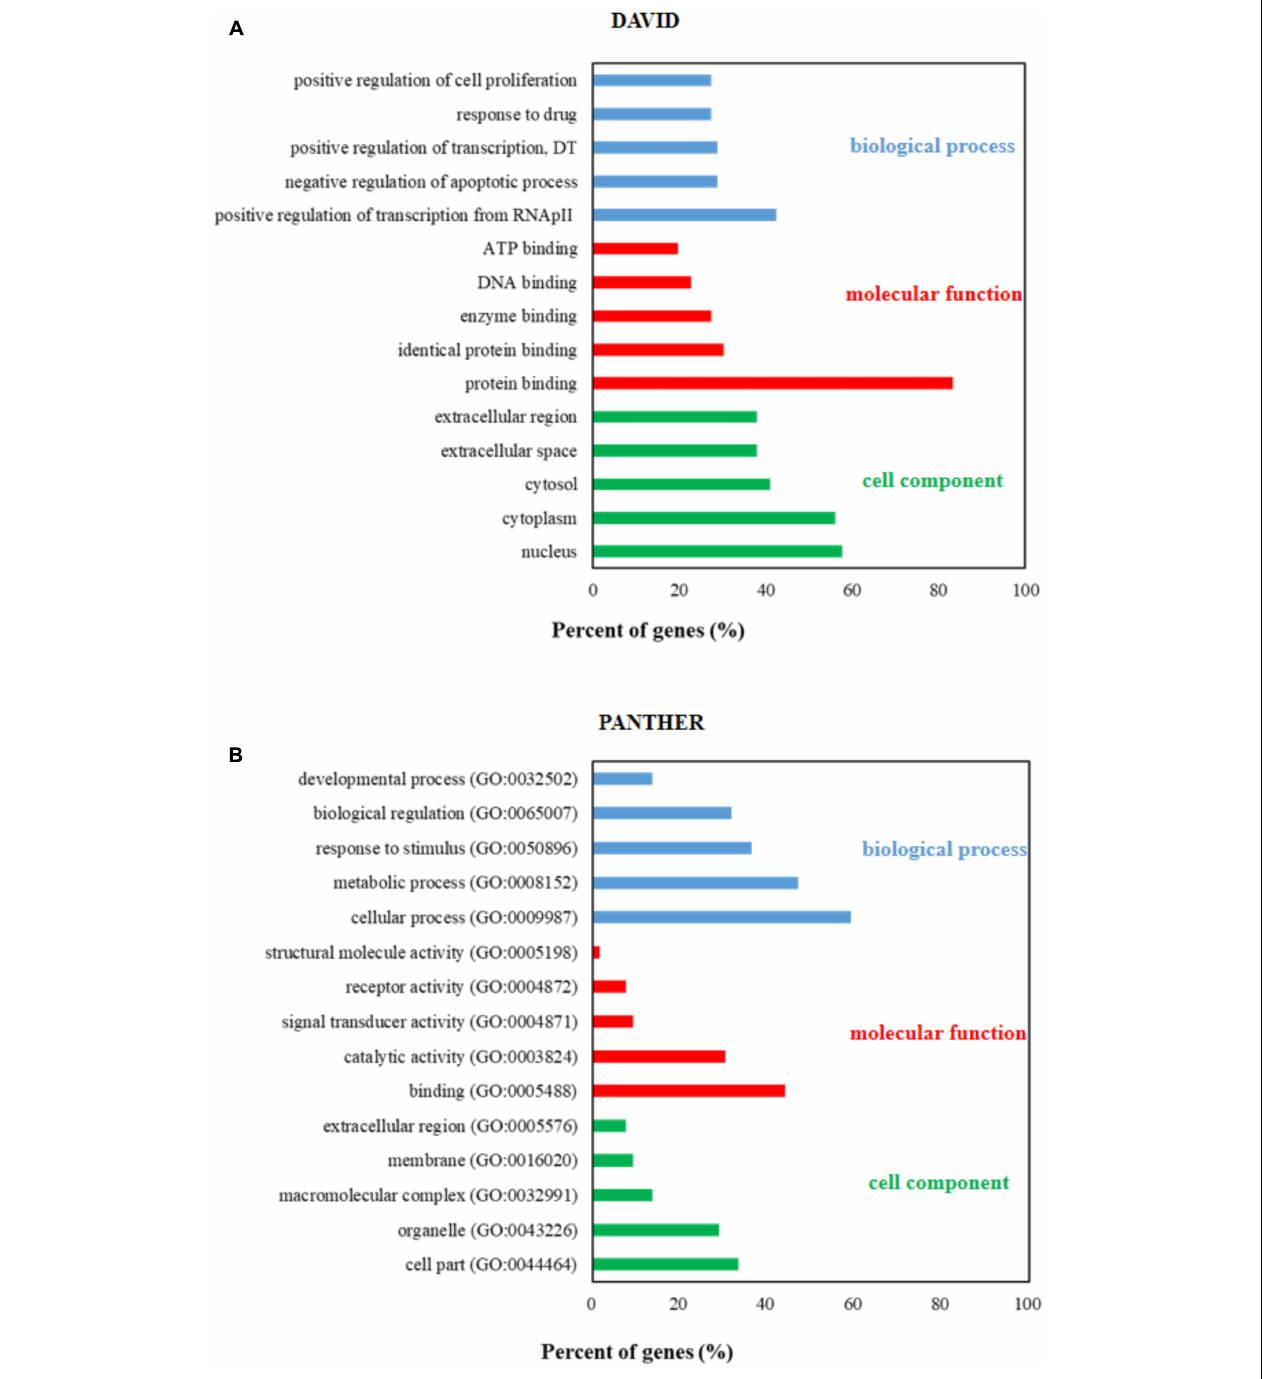
FIGURE 4 | Gene ontology (GO) analysis of candidate targets. GO enrichment analysis in DAVID (A) and PANTHER (B) database showed the five remarkably enriched items in the biological processes, cell component, and molecular function. RNApII, RNA polymerase II promoter; DT, DNA-templated.